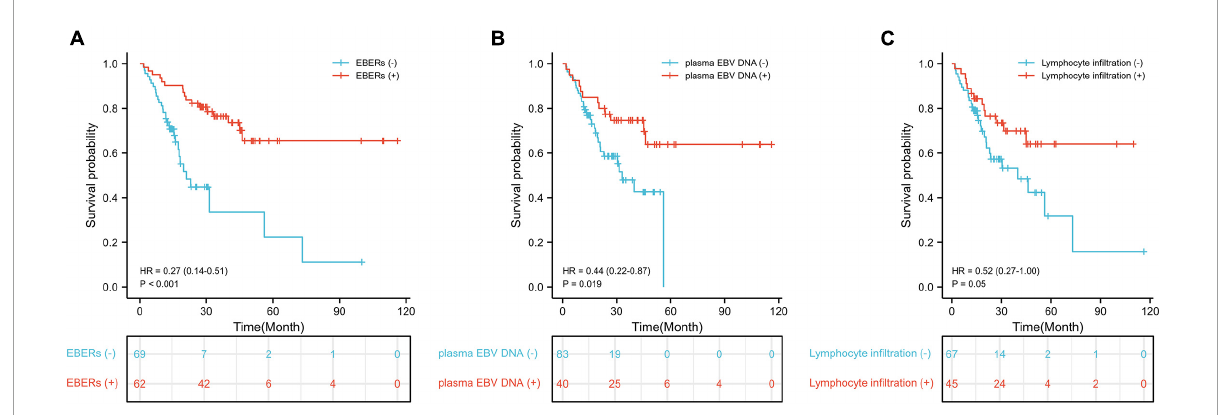
FIGURE5 Kaplan–Meier survival estimates of overall survival. (A) Survival curve according to EBERs staining; (B) survival curve according to plasma EBV DNA; (C) survival curve according to lymphocyte